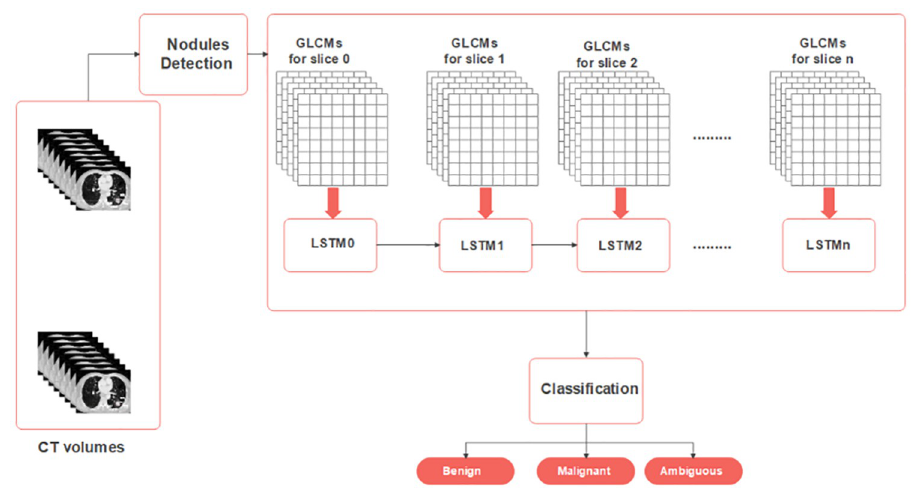
Fig 4. In 2.5D-GLCM mode the GLCMs computed for each slice are fed to the recurrent neural